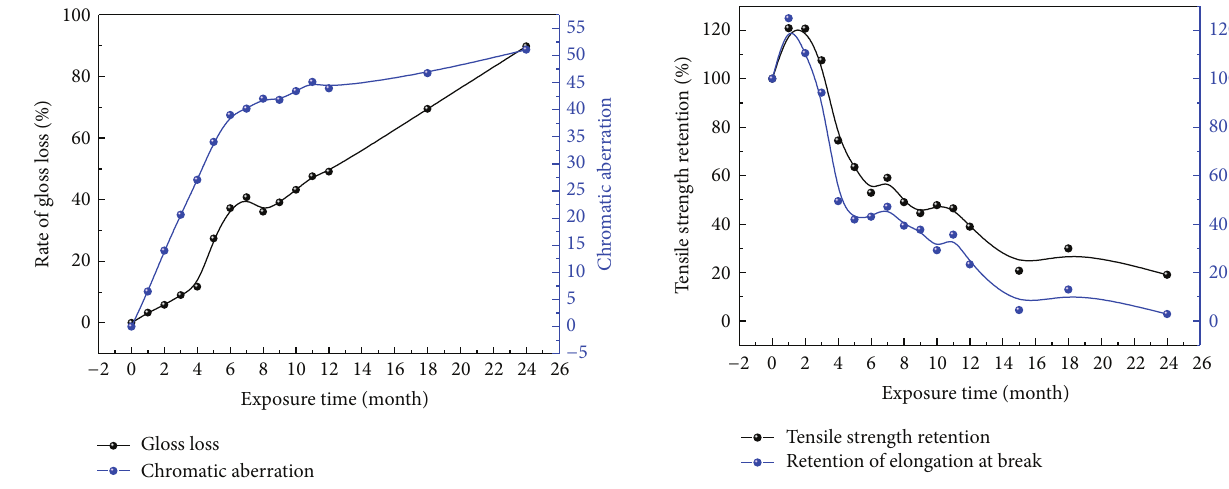
Figure 4: Change of the retention of tensile strength and that of elongation at break of PS with extended exposure time under the environment of Xisha Islands.